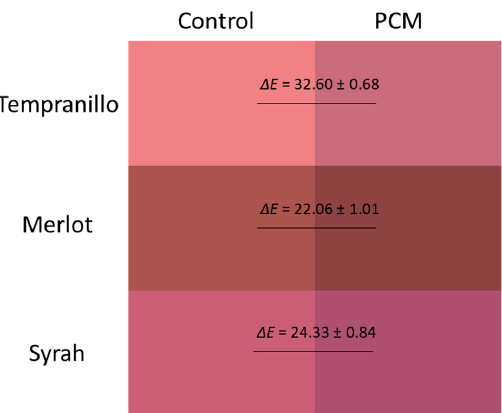
Figure 1. CIELAB representation of the samples and CIELAB color differences ( Δ E ) between pairs of samples.